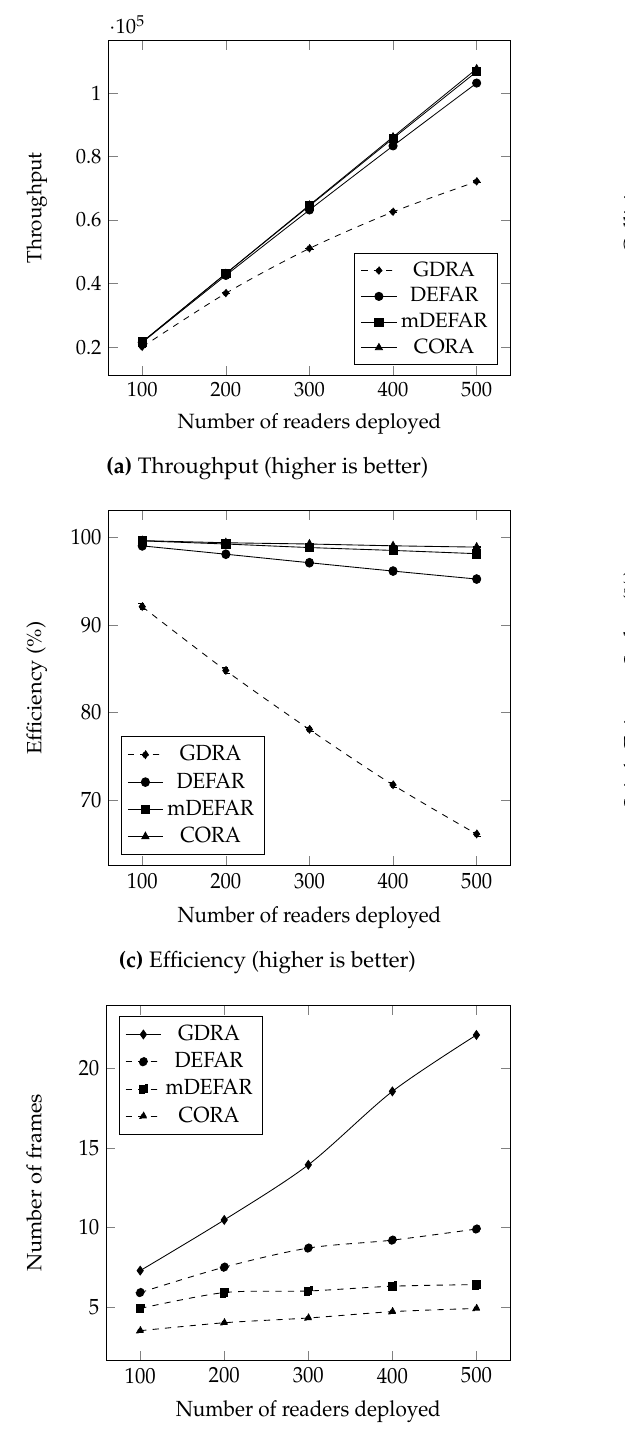
Figure 8. Performance evaluation